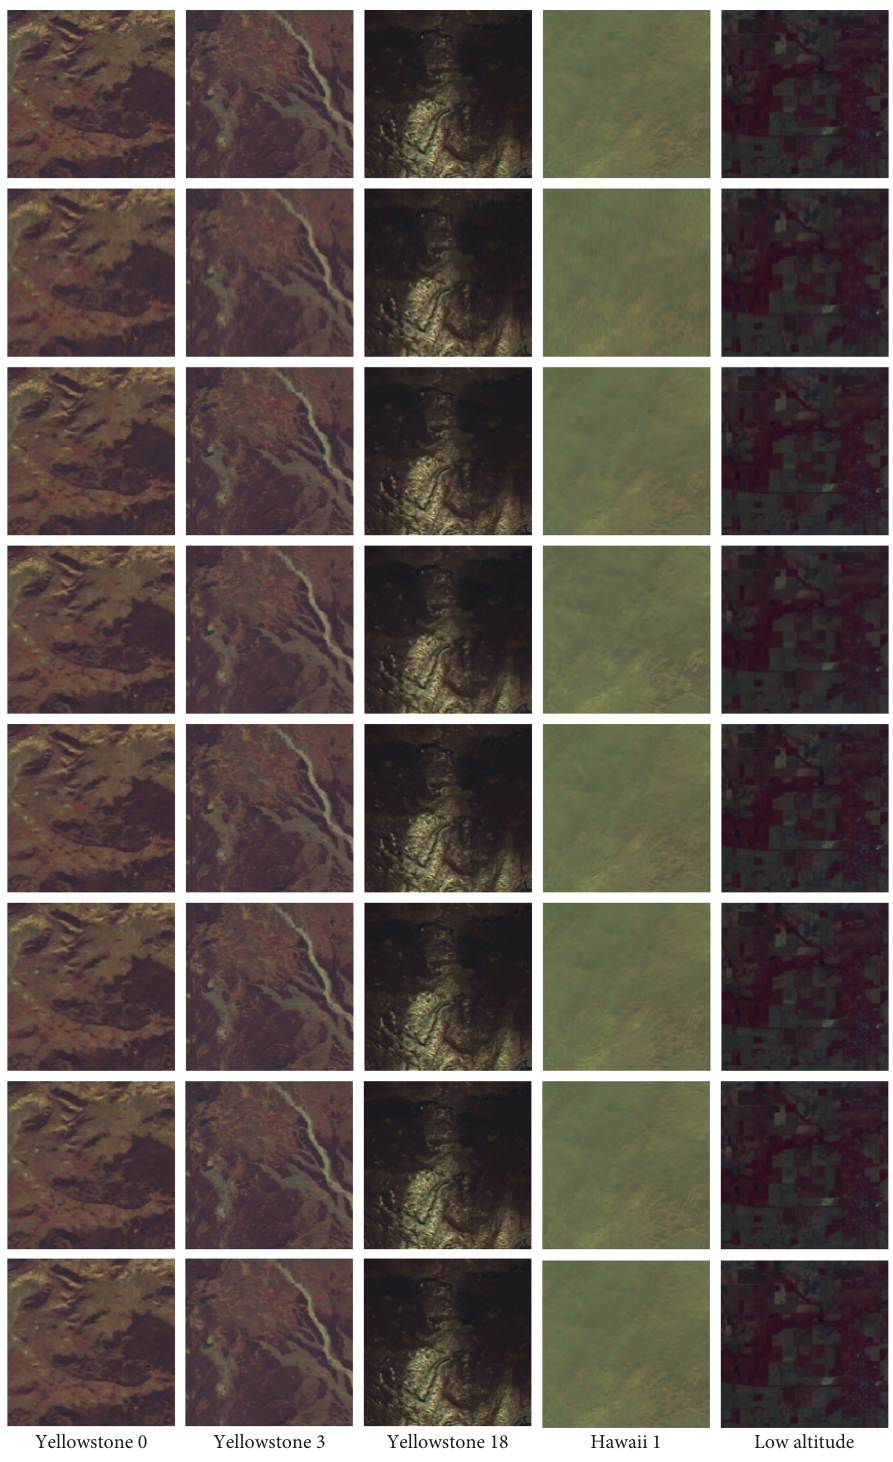
Figure 4: Original and reconstructed pseudo color images under the 0.2 sampling rate of all competitive algorithms; from top to bottom: Original, STNCS, JT-3DTV, E-3DTV, HSSTV, DCHS, DCS_SLM, and